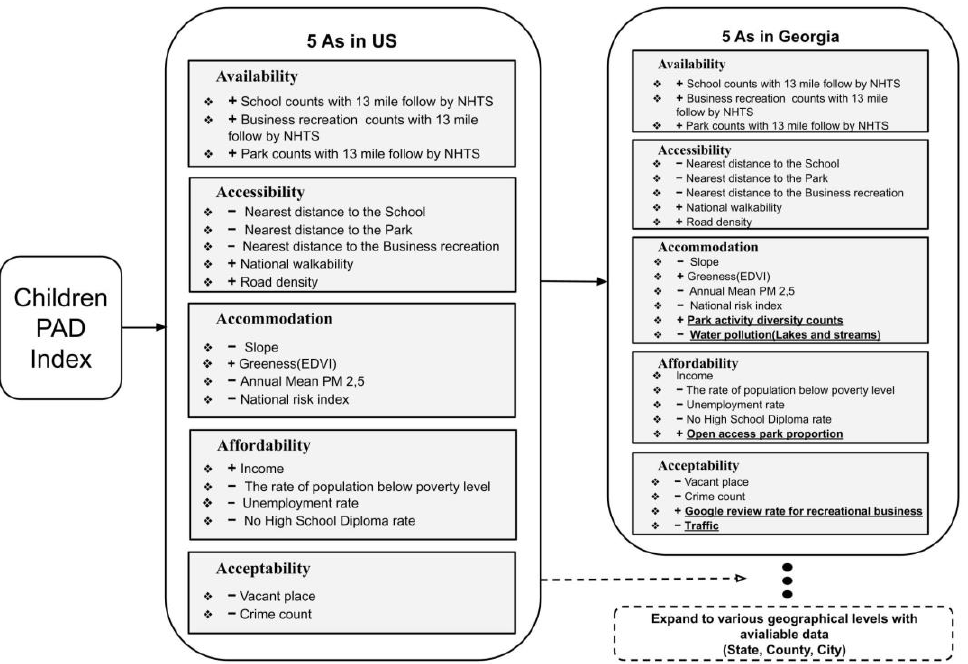
Figure 1. The variable distribution of 5 As for Children’s PAD indexes in the US and Georgia. Table 1. Environmental measures description.